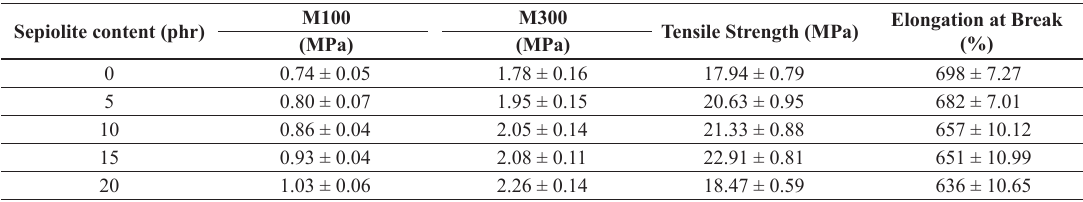
Table 5. Tensile properties of the unfilled and sepiolite filled NR composites. Sepiolite content